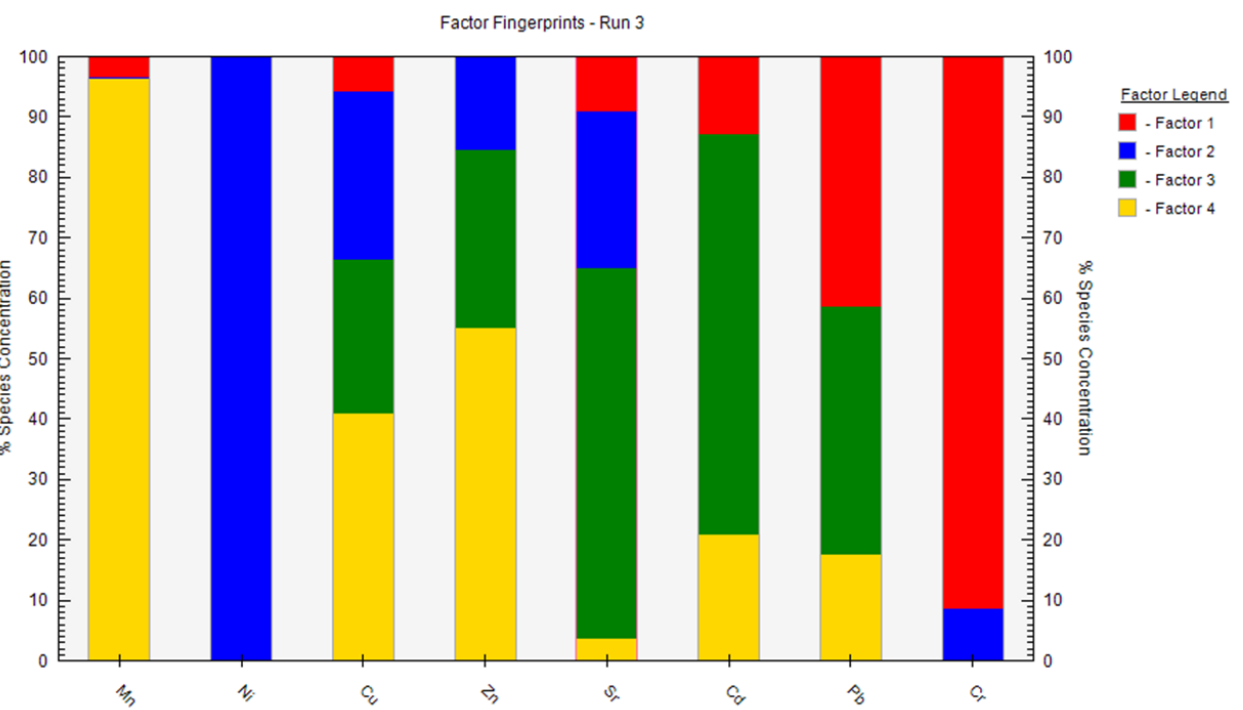
Figure 6. Heavy metal source identification results of PMF model.